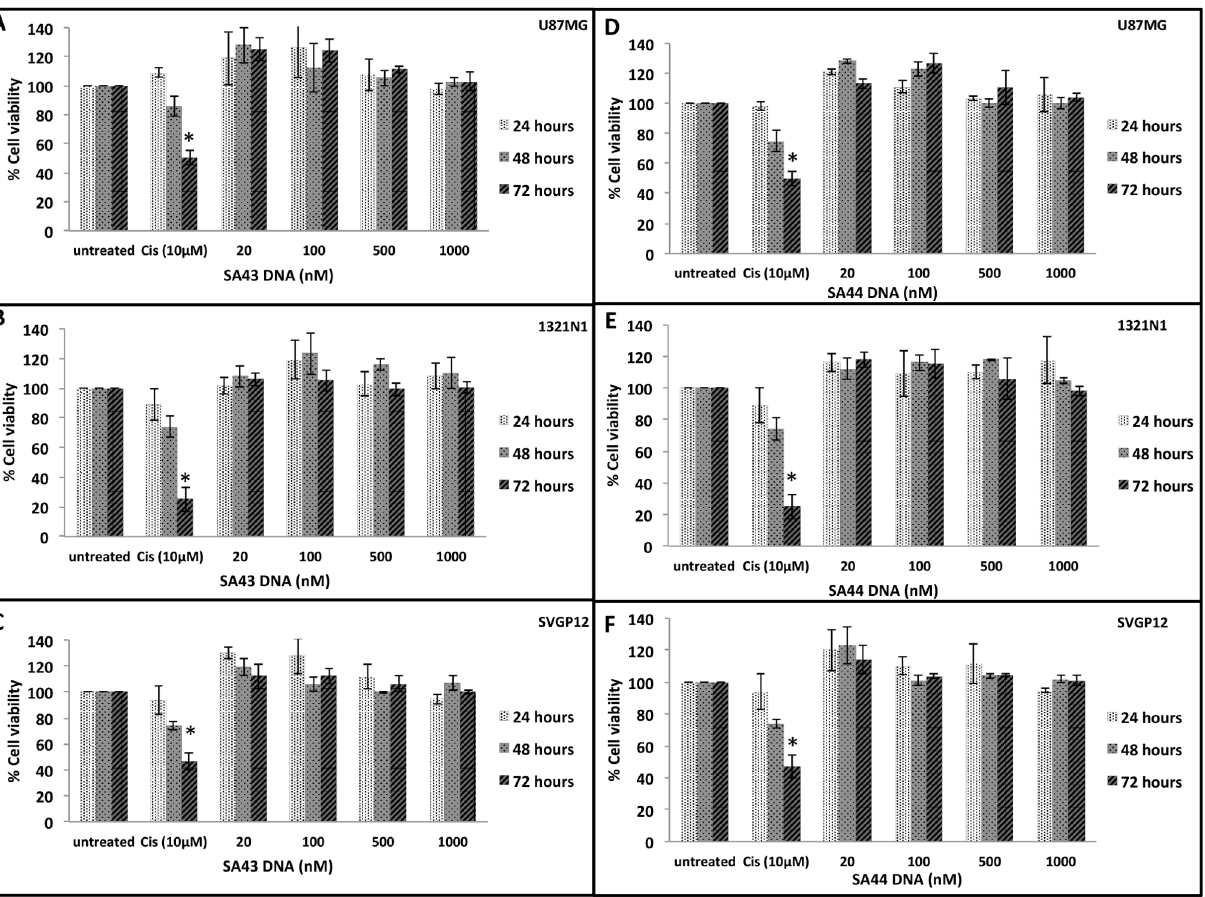
Fig 6. Effect of SA43 and SA44 DNA on cell viability using PrestoBlue assay. Live cells U87MG, 1321N1 and SVGp12 were incubated separately with SA43 and SA44 aptamer at concentrations of 20 nM, 100 nM, 500 nM and 1000 nM at 37°C (5% CO 2 ) and assessed for proliferation activity at 24, 48 and 72 hours using the PrestoBlue assay. Cisplatin at 10 μ M concentration was used as positive control. A two-way ANOVA test was performed to analyse the difference in the percentage cell viability of the SA43 and SA44 against cisplatin and untreated controls. A , B , and C represent no statistical difference between the percentage cell viability of SA43 and untreated controls for U87MG, 1321N1 and SVGp12 cells, respectively ( p > 0.05). D , E , and F represent no statistical difference between the percentage cell viability of SA44 DNA and untreated controls for U87MG, 1321N1 and SVGp12 cells, respectively ( p > 0.05). Cisplatin showed a significant decrease in the percentage cell viability at 72 hours when compared to SA43 and SA44 and untreated control ( * p < 0.05). All experiments were repeated at least three times. Data are mean of three independent samples. Error bars = Standard deviation.